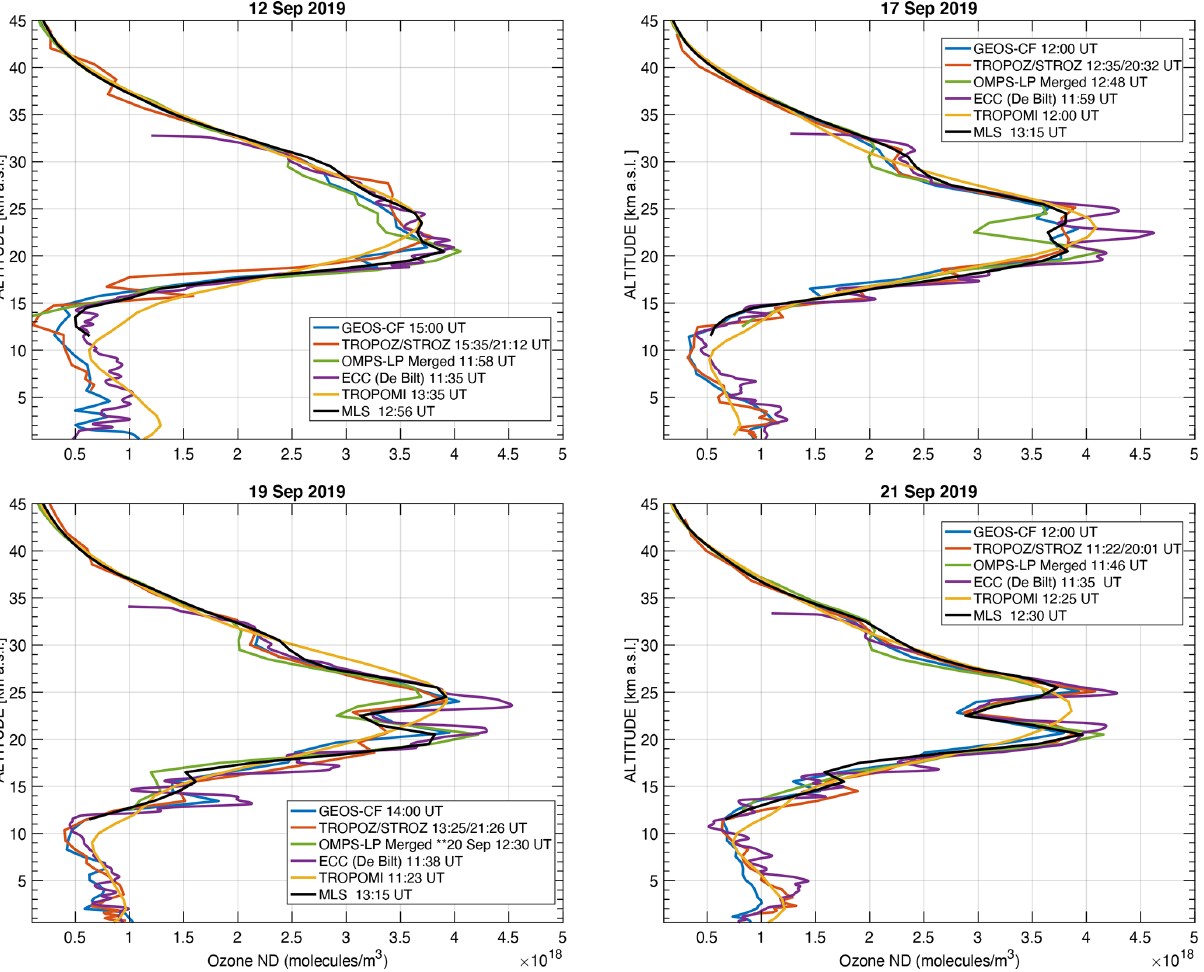
Figure 5. GEOS-CF, lidar, OMPS-LP, ECC, TROPOMI and MLS ozone profile comparisons for 12, 17, 19 and 21 September 2019. These days were selected as days within the campaign that had an ECC launch from De